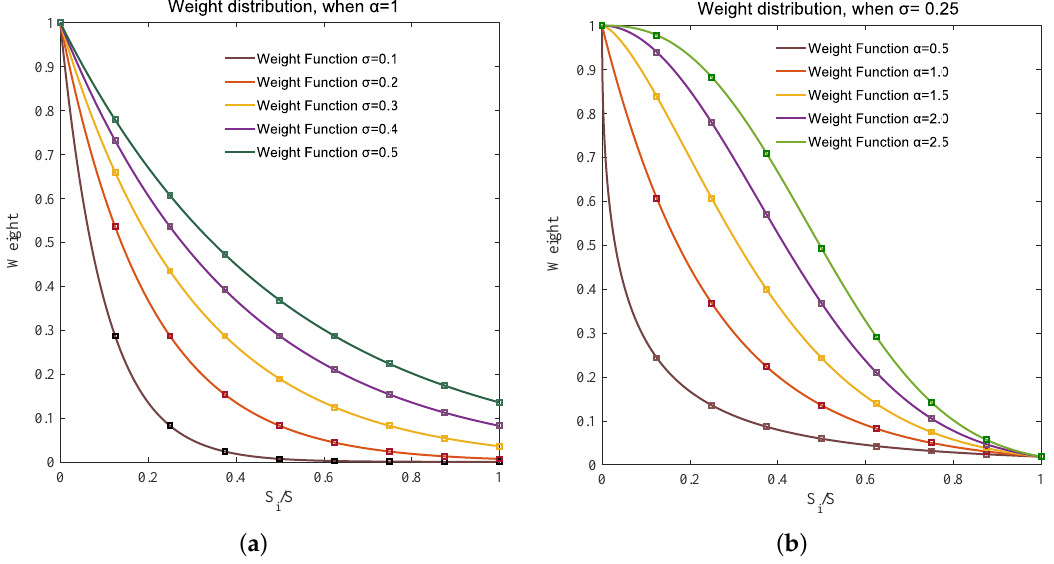
Figure 16. Differentweightfunctioncurveswithdifferentparametersofweightfunction. ( a )Thedistribution characteristics of the obscured link weight with different σ l values. ( b ) The characteristics of the obscured link weight distribution with different α